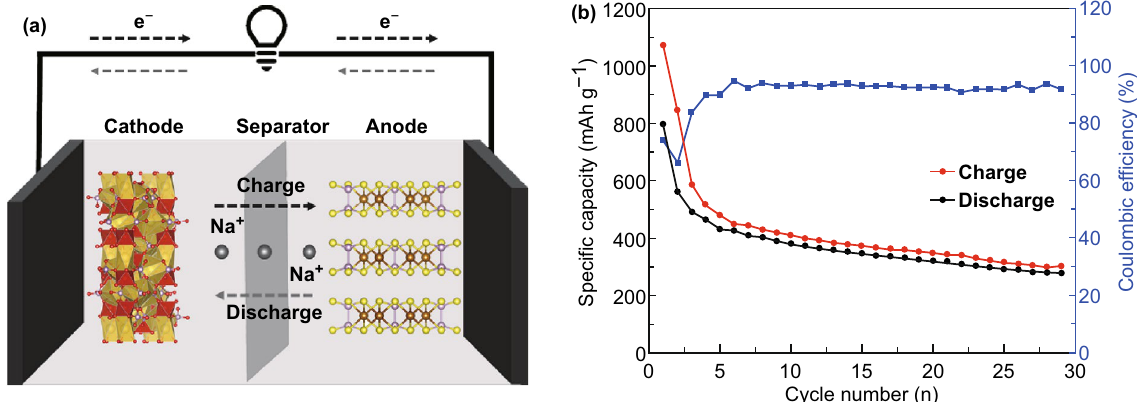
Fig. 7 a Structure schematic of the full cell. b Cycling performance at 0.1 A g −1 as to